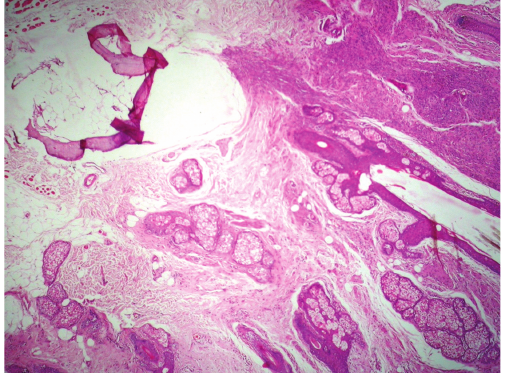
Figure 3: Lamellar bone which is seen adjacent to nevus cells (H&E,